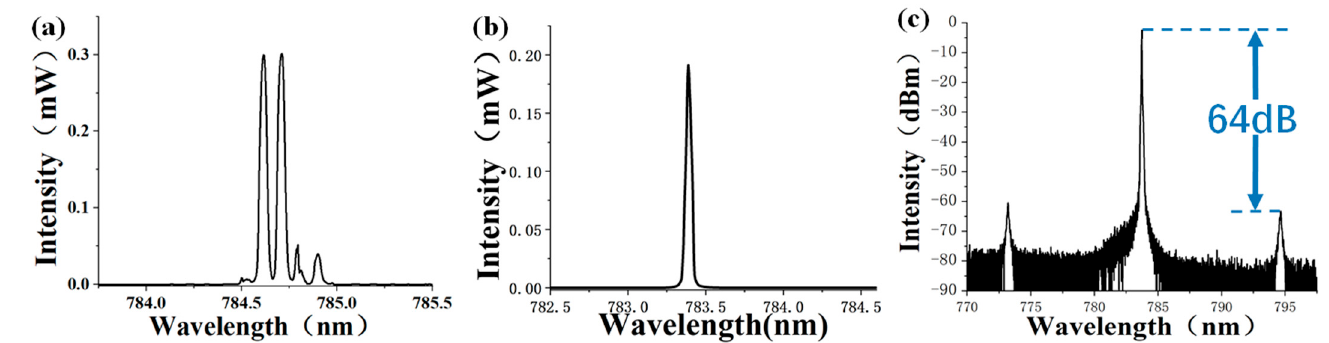
Figure 3. ( a ) The free-running spectrum of the laser diode. ( b ) The spectrum of the self-injection- locked laser diode. ( c ) The spectrum in the logarithmic scale.